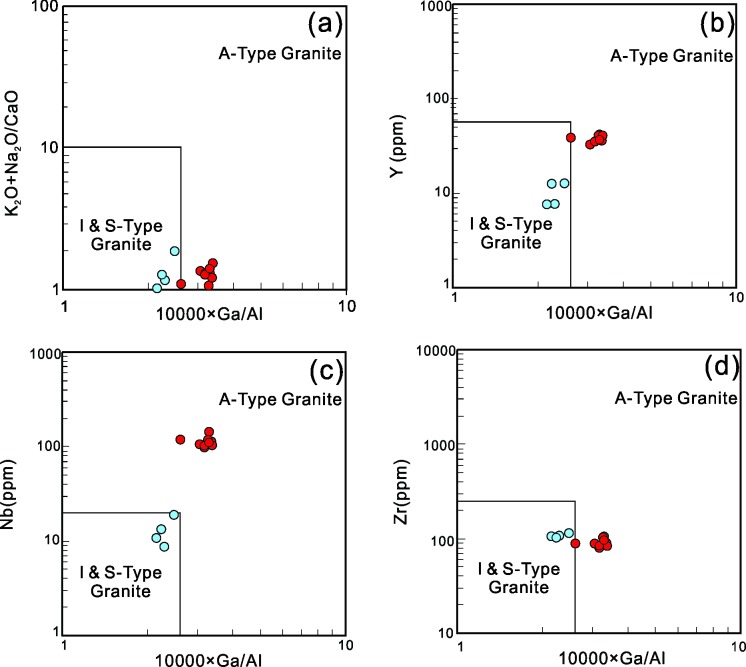
(K2O+Na2O) (a), Y (b), Nb (c), Zr (d)-10000 Ga/Al diagram(after [78]) of the granites from the NIC. Symbols are same as Fig 6.